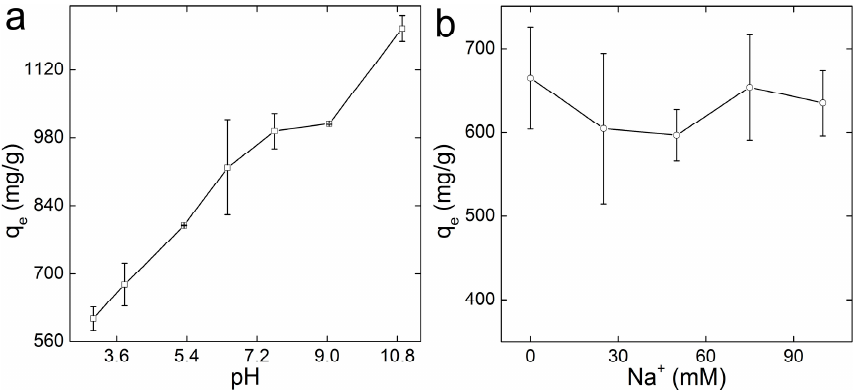
Figure 6. Adsorption of MB on GO-COOH sponge at different pH ( a ) and ionic strength ( b ) values.